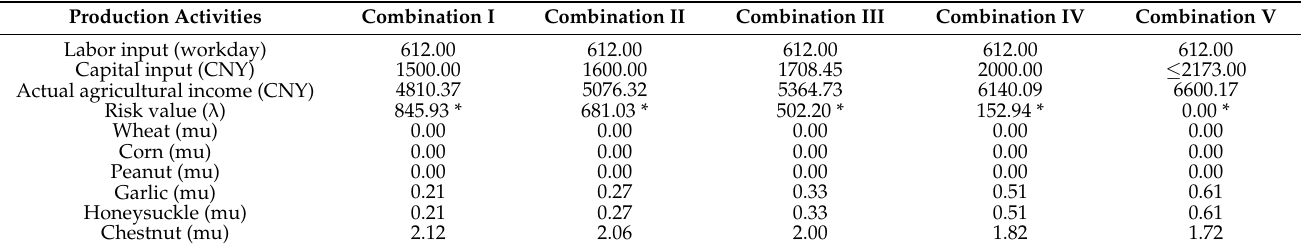
Table 12. Optimization of capital input for NAPH .